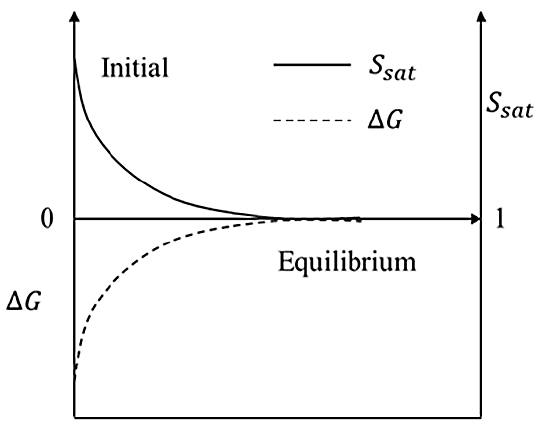
Figure 2. Schematic of driving force chemical changes during inclusion formation.